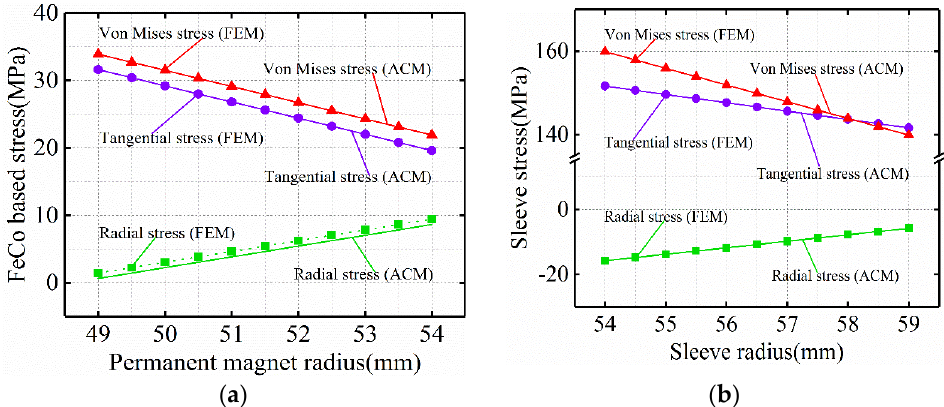
Figure 13. Stress distribution of ( a ) FeCo-based PM and ( b ) sleeve under hot rotating condition.